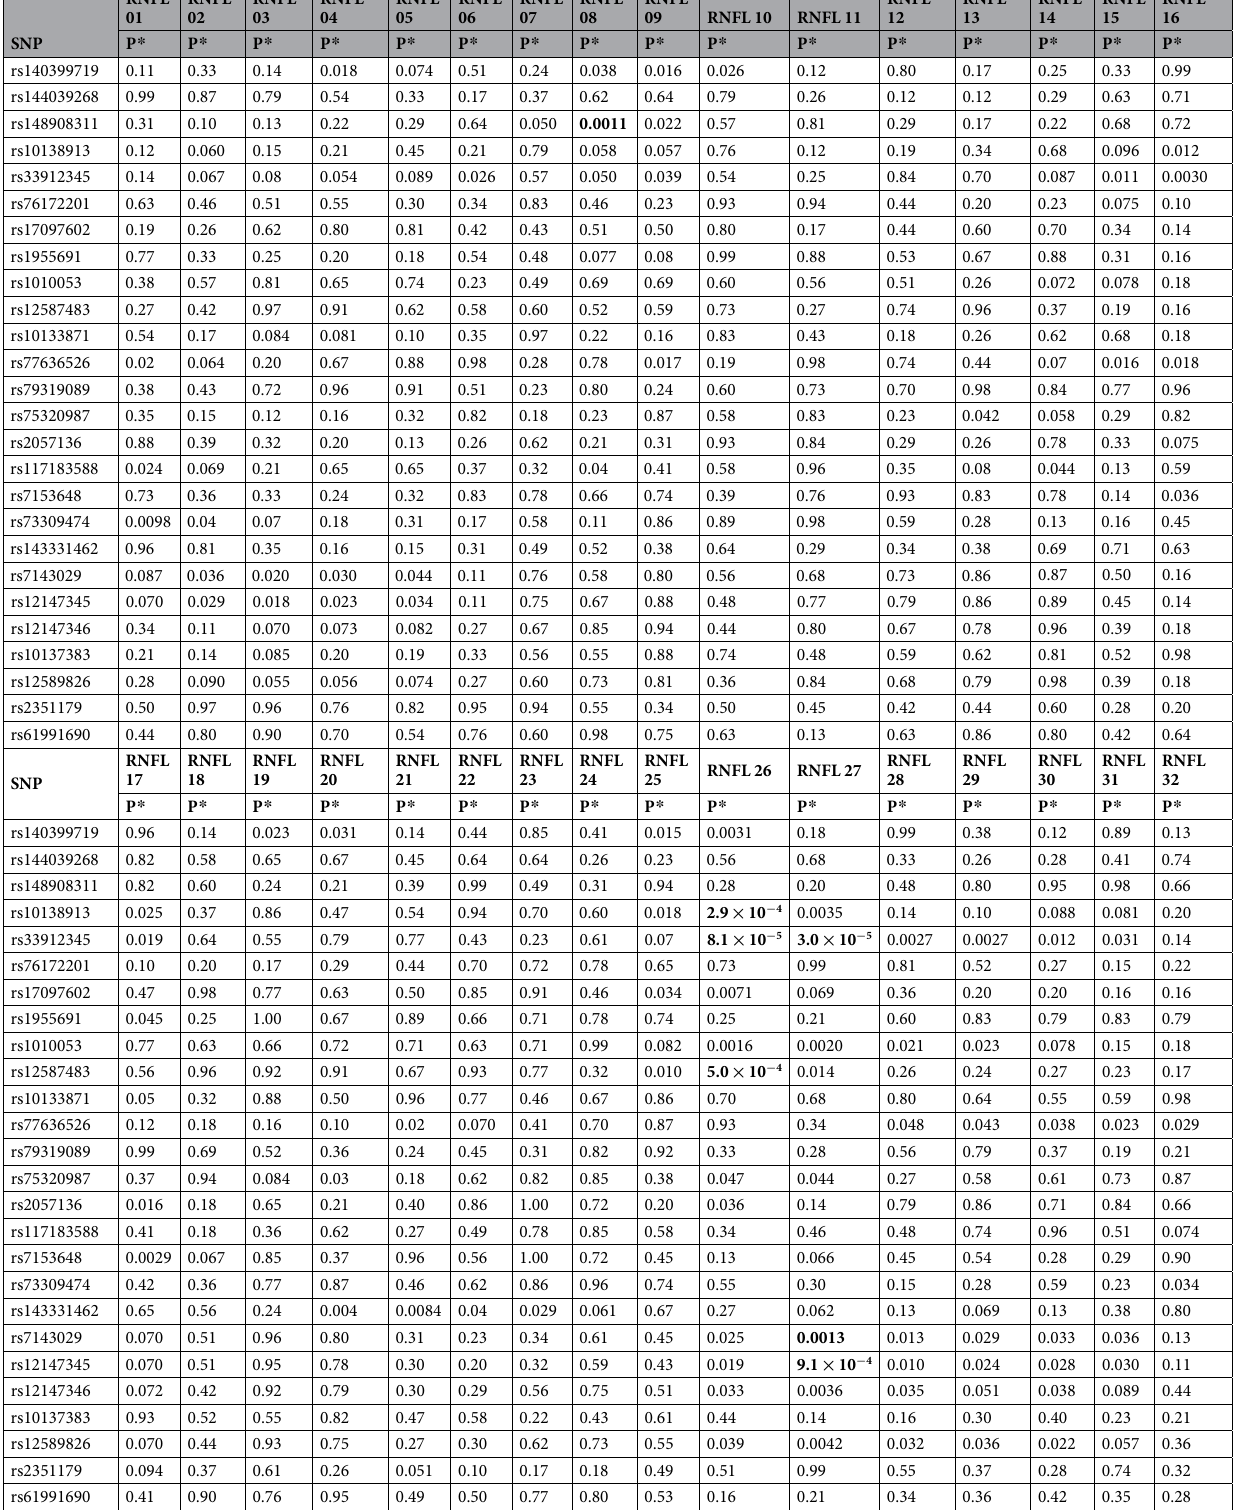
Table 3. Associations of SIX1/SIX6 locus polymorphisms and circumpapillary retinal nerve fibre layer thickness in 32 sectors. SNP, single nucleotide polymorphism; RNFL, retinal nerve fibre layer. RNFL01–32 starts from the temporal region at 0–11.25° and at 11.25° ( = 360°/32 sectors) interval (clockwise direction). * Linear regression analyses were applied assuming additive effect of the per minor allele variant, adjusted for age and sex. Significant (P < 6.0 × 10 − 5 ) or suggestive ( < 1.6 × 10 − 3 ) associations are shown in